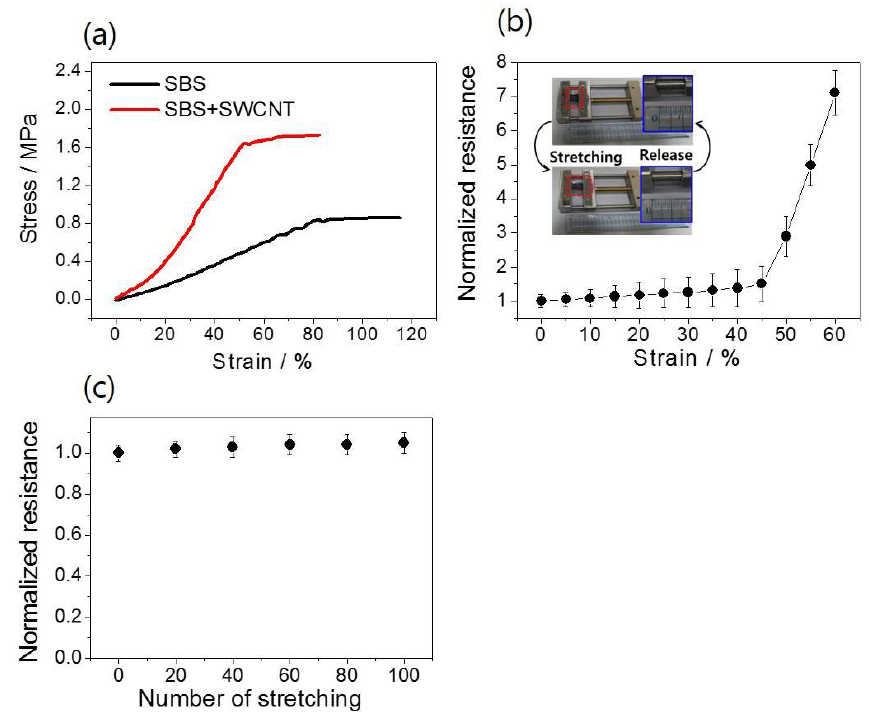
Figure 4. Mechanical and electrical properties of the SWCNT/SBS nanofiber mat electrodes. ( a ) strain-stress curve for SBS and SWCNT-coated SBS nanofiber film; ( b ) Variation of the normalized sheet resistance as a function of the applied strain for Zonyl-treated SWCNT/SBS nanofiber mat electrodes. The inset shows the photograph of the stretching apparatus at different stages of the stretch/release cycle; ( c ) Normalized resistance as a function of the number of stretching cycles at 40% strain.